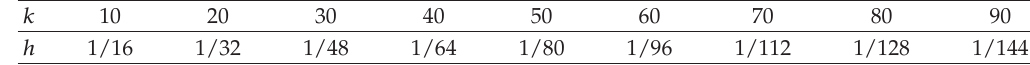
Table 1: Discretization steps related to